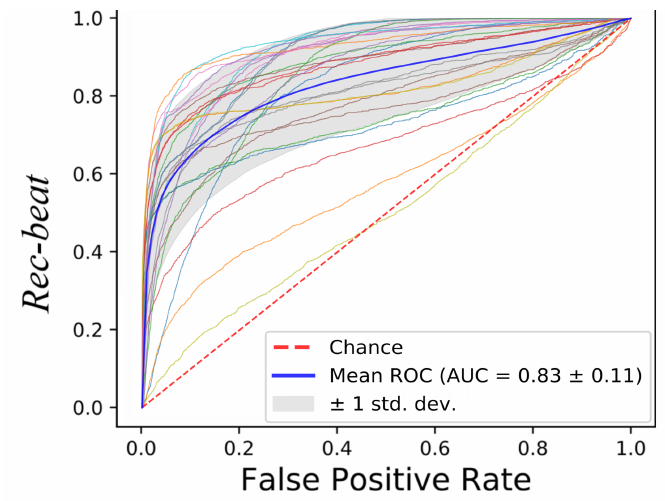
Figure 10. Receiver operating characteristic (ROC) curves obtained when classifying the full-length (10-min long) LDV signals with Support Vector Machines (SVM).